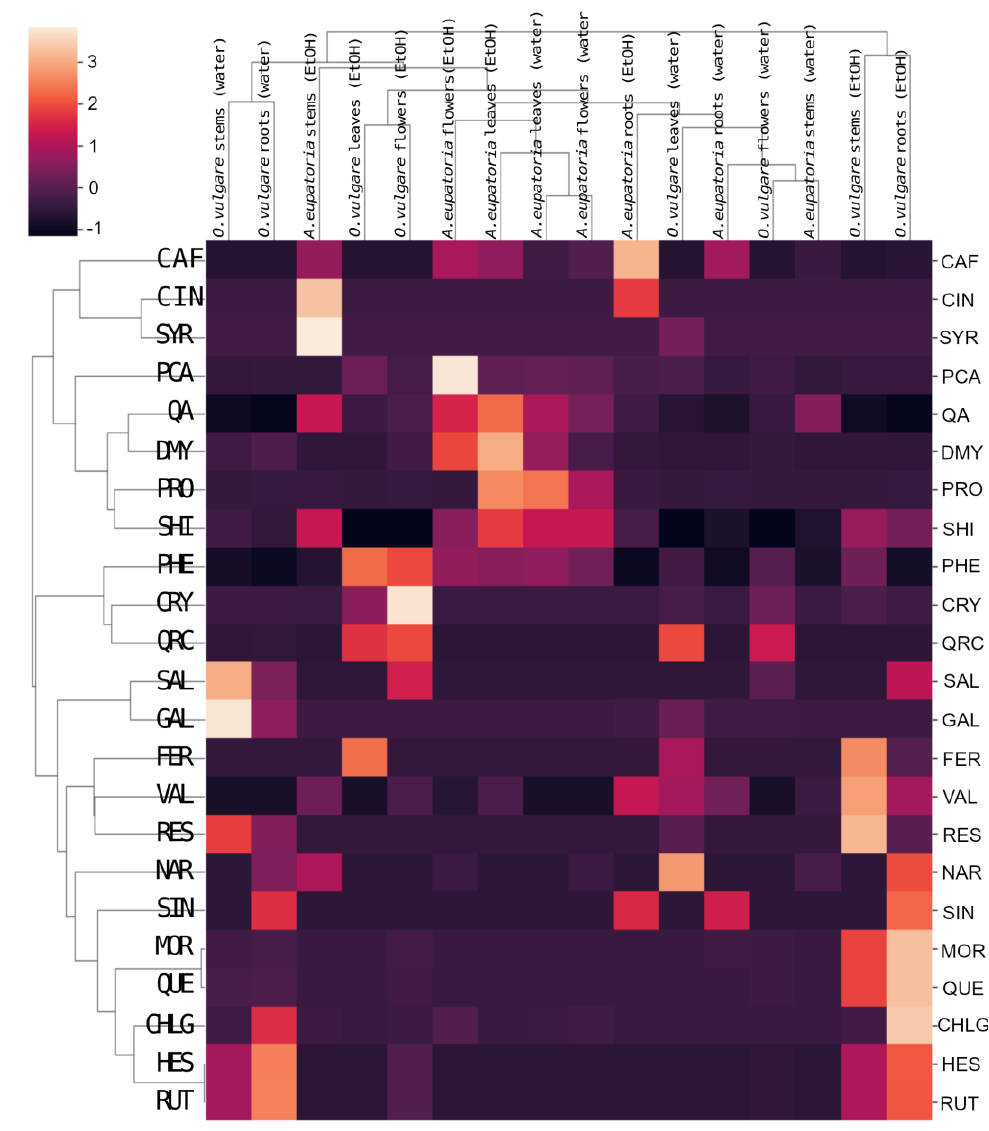
Figure 5. Heatmap with dendrogram of hierarchical clustering of secondary metabolites identified in water or 60% ethanol extracts of A. eupatoria and O. vulgare . The analysis compares the composition of the extracts against PA-Lux. Data were plotted using the Seaborn library for statistical graphics in Python [26]. Abbreviations: CAF, caffeic acid; CHLG, chlorogenic acid; CIN, trans -cinnamic acid; CRY, chrysin; DMY, dihydromyricetin; FER, trans -ferulic acid; GAL, gallic acid; HES, hesperidin; MOR, morin; NAR, naringin; PA-Lux, luminescent strain of P. aeruginosa ; PCA, p -coumaric acid; PHE, phenylalanine; PRO, protocatechuic acid; QA, quinic acid; QRC, quercitrin; QUE, quercetin; RES, resveratrol; RUT, rutin; SAL, salicylic acid; SHI, shikimic acid; SIN, sinapic acid; SYR, syringic acid; VAL, vanillin.